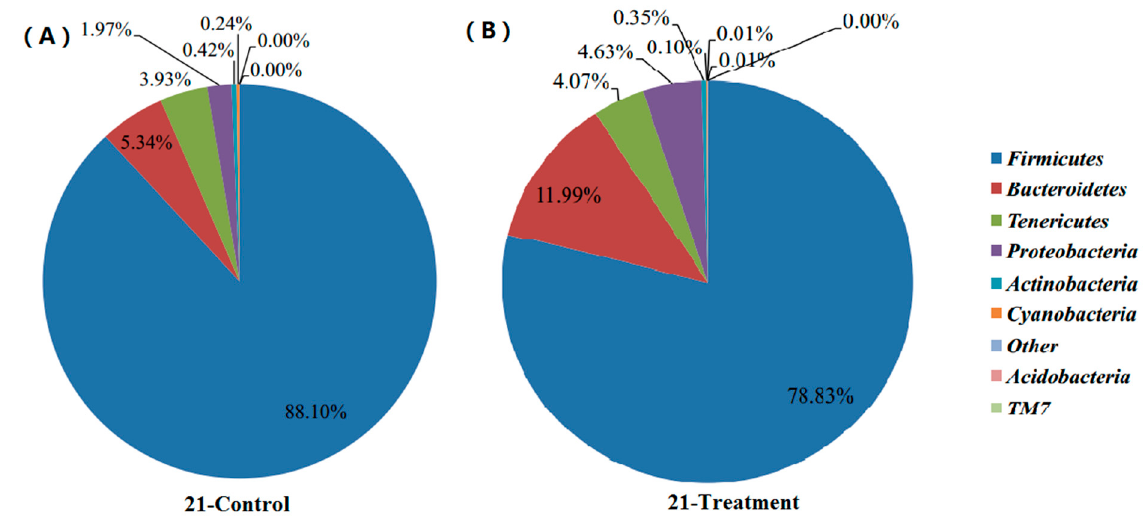
Figure 1. Effects of lecithin on the profiles of cecal microbial community after 21 days according to phylum for the control group ( A ) and lecithin treatment group ( B ).